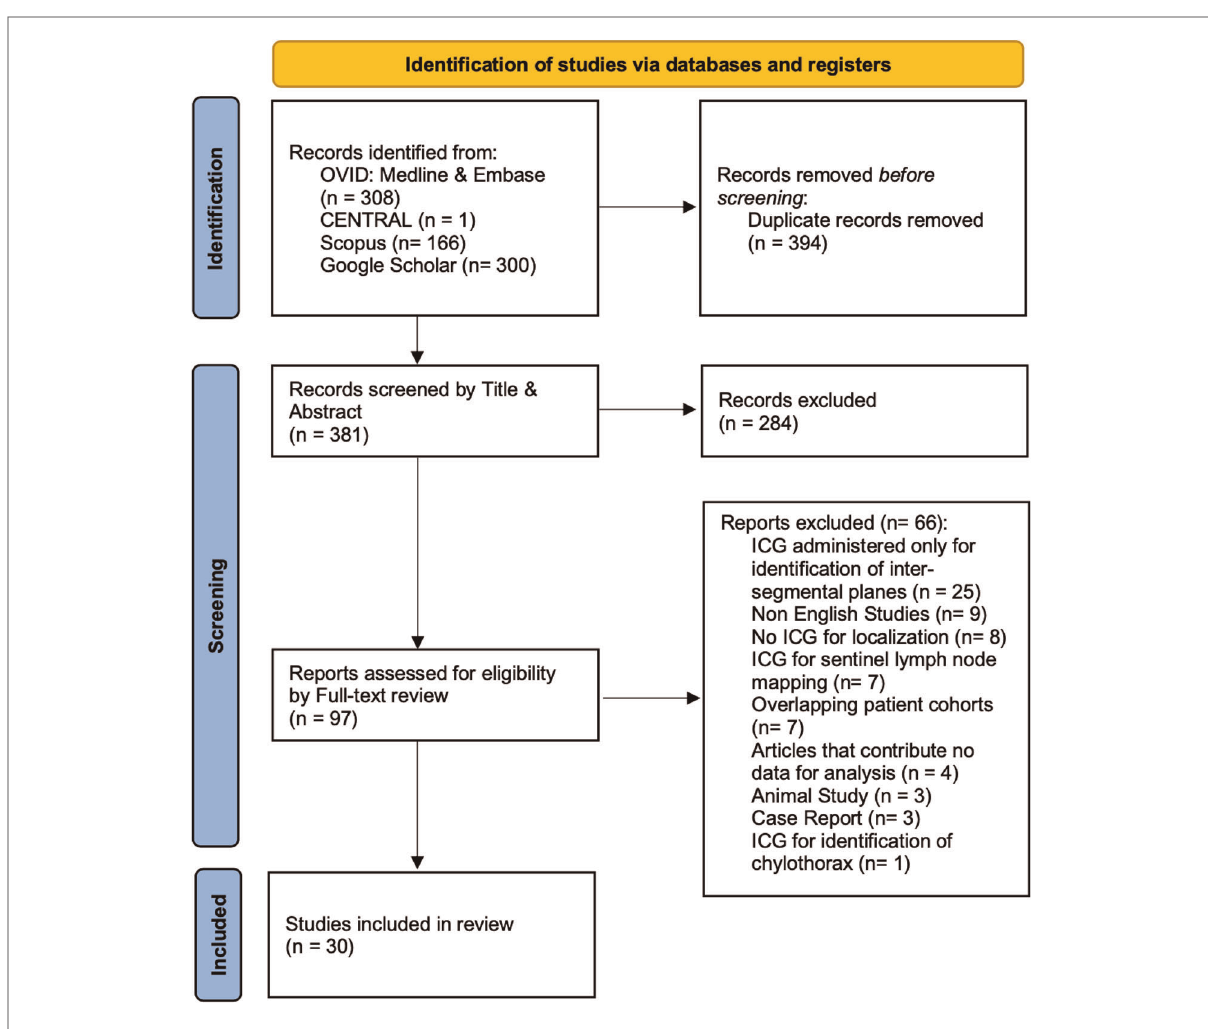
FIGURE 1 PRISMA fl ow diagram. ICG: Indocyanine